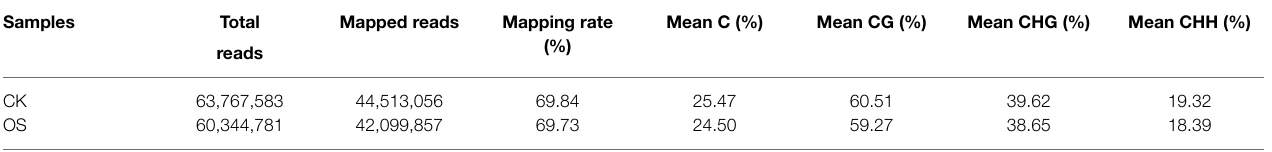
TABLE 2 | Data summary of whole genome bisulfite sequencing.